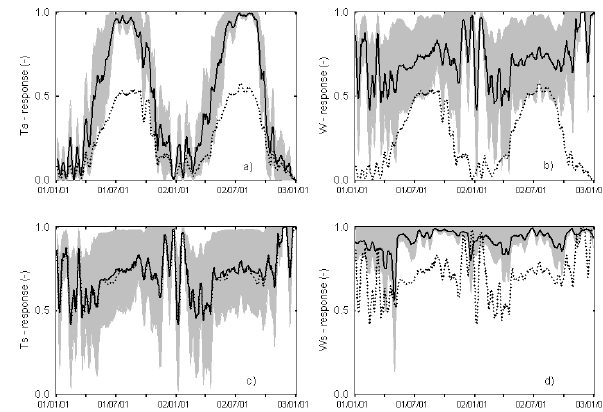
Fig. 9. Seasonal patterns of the effects of simulated daily response functions on photosynthesis processes (a and b) and on transpiration processes (c and d) during 2001-2002 for dry soil conditions. The different responses originate from air temperature (a), transpiration/water uptake by roots (b), soil temperature (c) and soil moisture (d). The grey area is the min-max response band based on 204 behavioural models using the DryTs model assumption when constrained by C2. The black solid line represents the mean of 204 behavioural individual responses, and the dotted line represents the multiplicative total response (including nitrogen for photosynthesis; (a) and (b)). All values are 5-day averages.